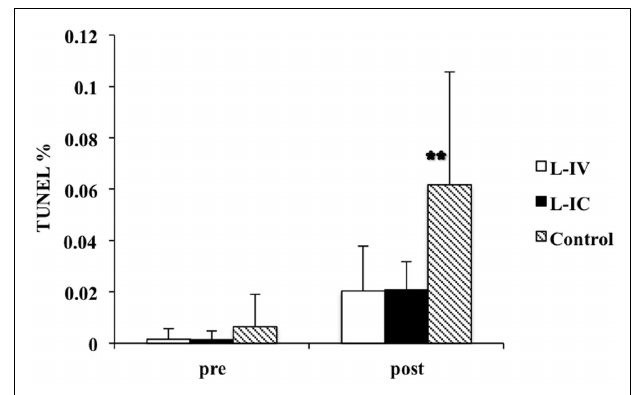
FIGURE 3 | Cardiomyocyte apoptosis as detected by theTUNEL assay in the left ventricular myocardial biopsies obtained before (pre) and after (post) the ischemia–reperfusion. L-IV, levosimendan infusion-group; L-IC, intracoronary levosimendan-group. **Post L-IV vs. post control p = 0.03, post L-IC vs. post control p = 0.03.